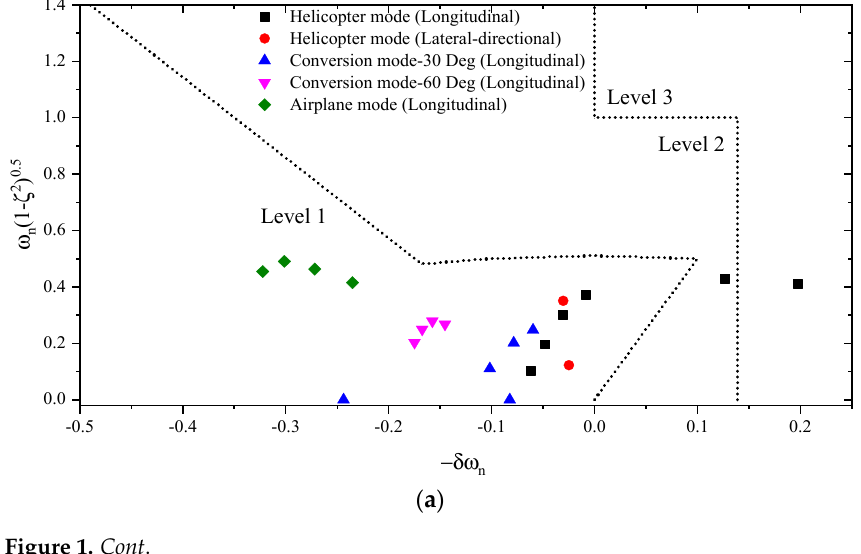
Table 1. Aerodynamic interference calculation